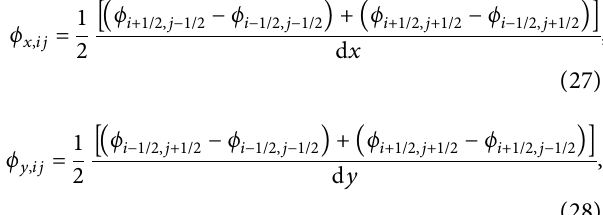
Figure 9: Wavefront error (lenses resolved as 600 × 600 grids).